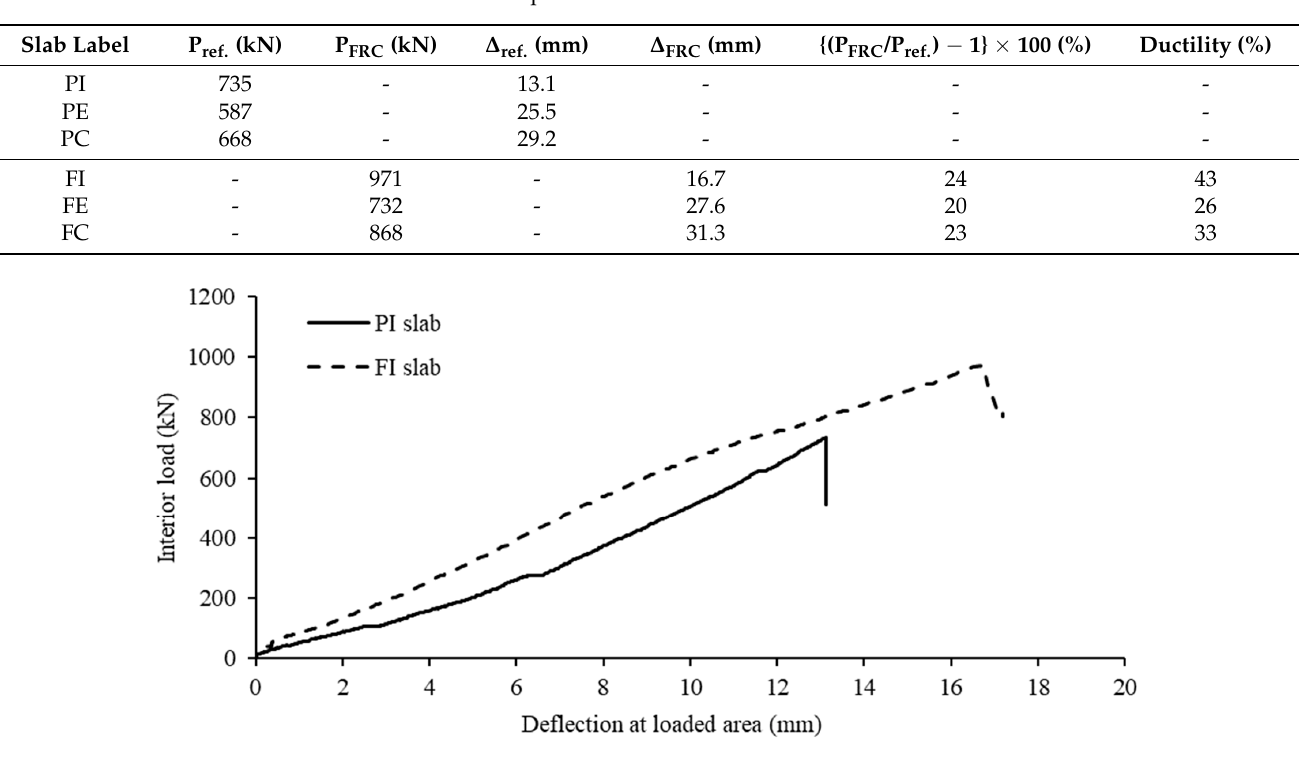
Figure 12. Interior load versus deflection at the loaded area of PCC and MSFRC slabs.